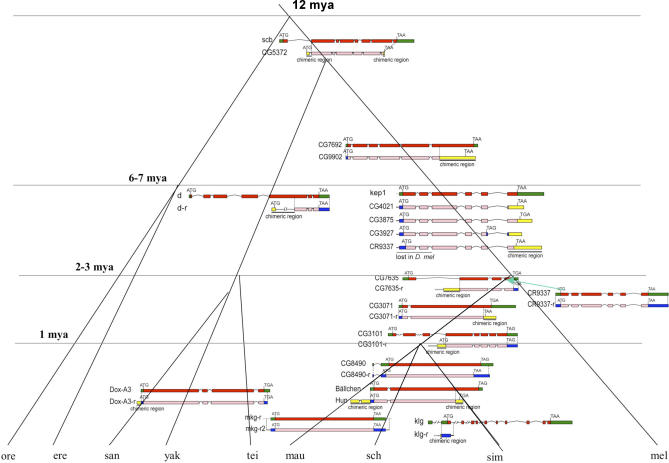
The Gene Structures of 16 New Duplicates Mapped on the Species PhylogenyCR33318 is not shown because it is a truncated copy without detectable expression and has frame shift mutations. Duplicated regions are indicated with vertical dash lines. Horizontal dash lines in CG7635-r, CG3101-r, d-r, and klg-r indicate that we only obtained partial coding regions with RT-PCR and longer coding regions may exist outward. Boxes are exon regions and lines indicate introns. Yellow boxes indicate recruited chimeric regions, green boxes indicate parental loci UTRs, and blue boxes indicate duplicate loci UTRs. Positions of start and stop codons are marked.